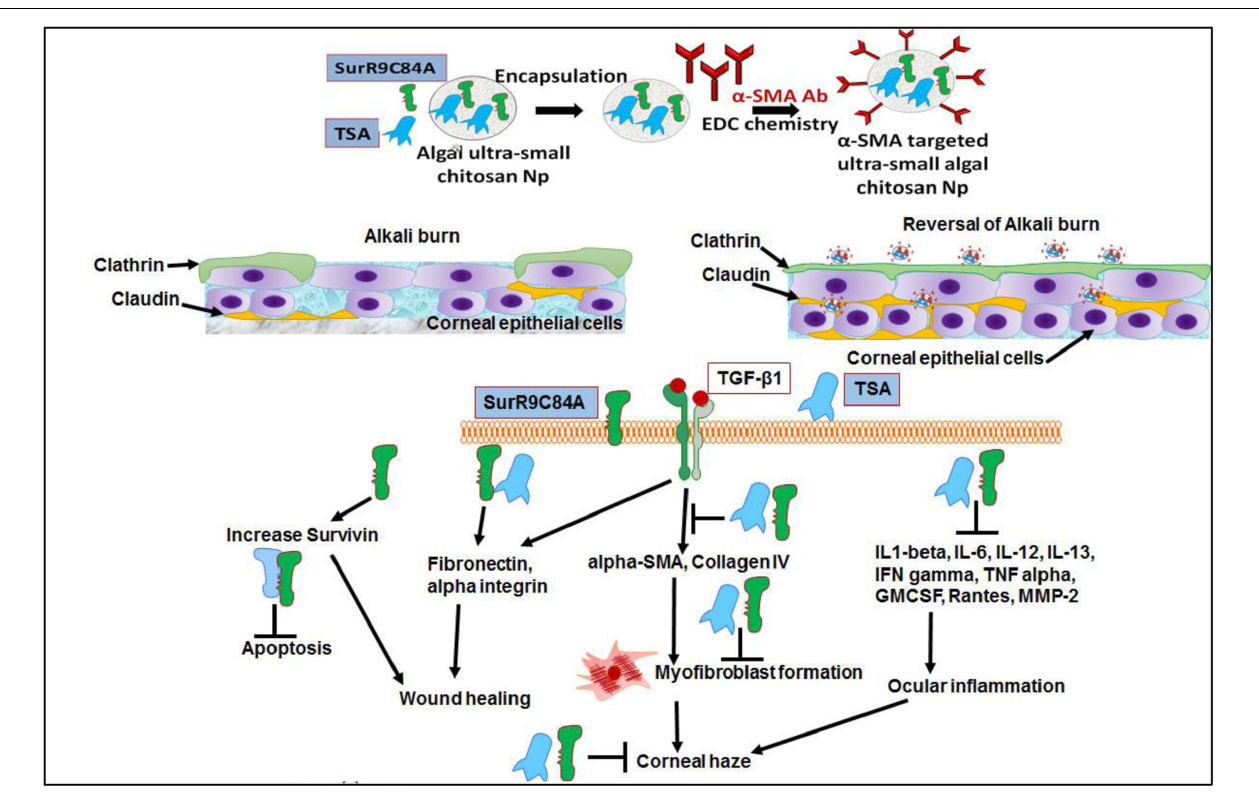
FIGURE 7 | Alpha-SMA targeted USC NPs for delivery of TSA and SurR9-C84A to the burn site and reverses corneal haze by inducing apoptosis in TGF-beta-1 induced transformed myofibroblast cells: The alpha-SMA targeted USC NPs have the potential for specifically delivering majority of the therapeutic to the burn site in a sustained release manner thus ensuring a longer activity period of the therapeutics. The combinatorial treatment of SurR9-C84A and TSA can repair of the conjunctival and corneal integrity by reinstating expression of clathrin and claudin without inducing any non-specific cytotoxicity. TSA and SurR9-C84A treatment increased expression of survivin: preventing apoptosis, TGF-beta-1: initiating wound healing, fibronectin, and alpha integrin: reinstating the corneal integrity. Key markers of corneal haze progression (alpha-SMA and collagen type IV) were effectively downregulated therefore reducing the risk of myofibroblast